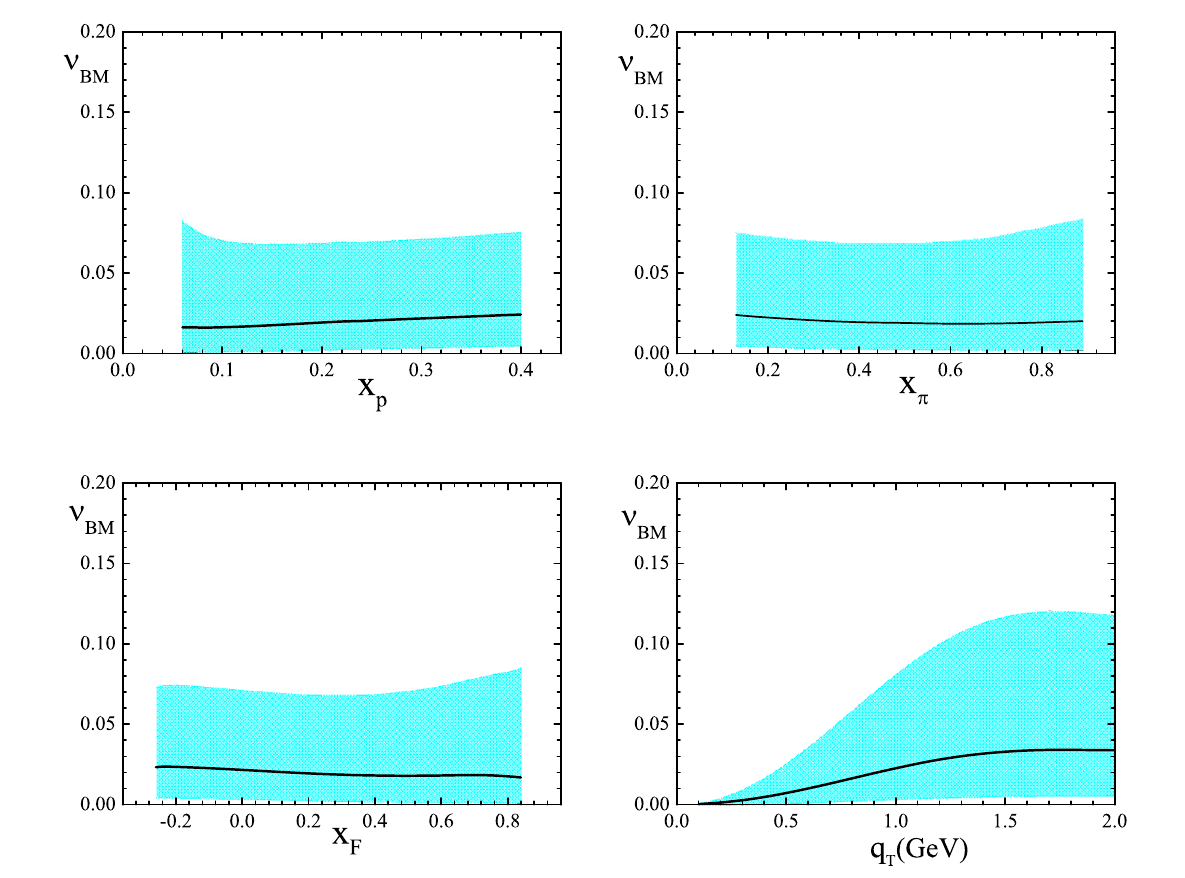
Fig. 2 The cos2 φ azimuthal asymmetries ν BM as the functions of x p (upper left), x π (upper right), x F (lower left) and q T (lower right) for the unpolarized π p Drell–Yan process considering the TMD evo-